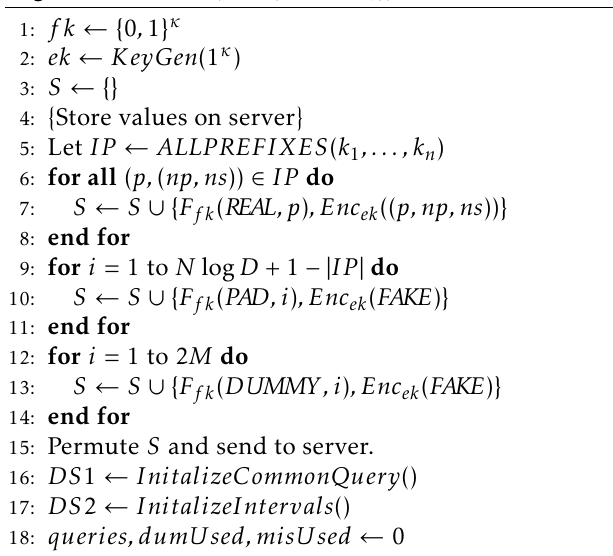
Algorithm 3 INIT ( K = { k 1 , . . . , k